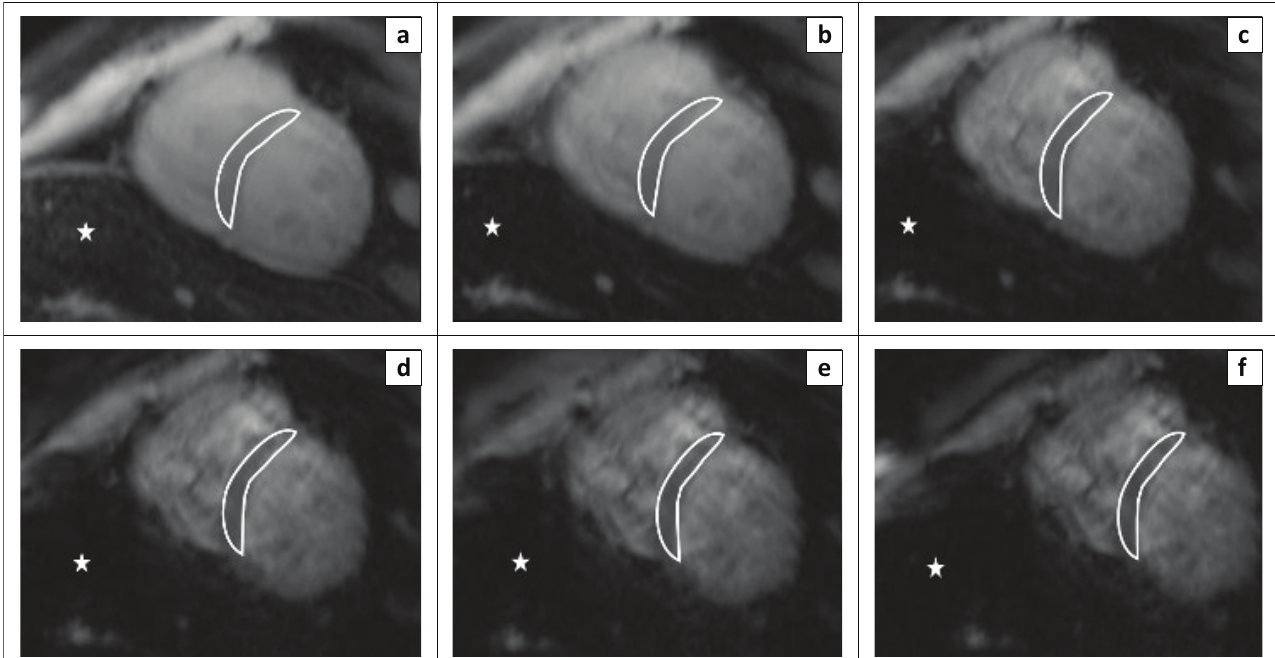
FIGURE 13: Serial short-axis T2 * images at the mid ventricular level at different echo times. The ROI for T2 * assessment is drawn to include as much of the myocardium as possible, excluding the blood pool in both ventricles. The signal loss in the liver ( * ) owing to iron infiltration can also be seen.